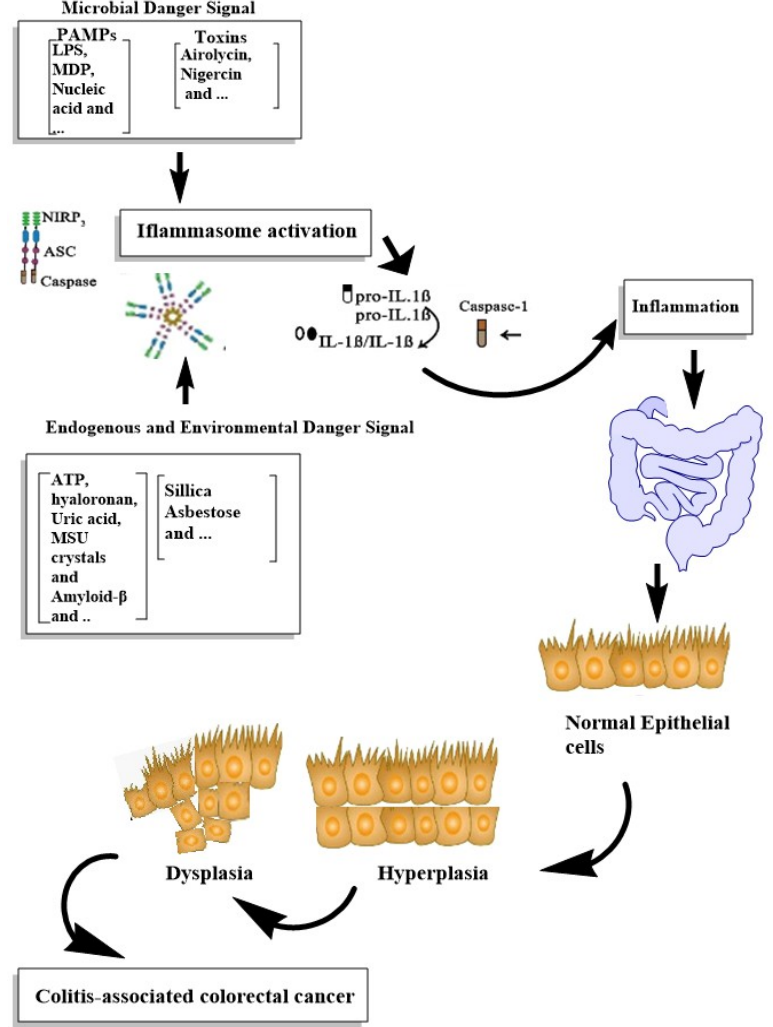
Figure 2. Summarizing the roles of inflammasome activation in IBD progression to